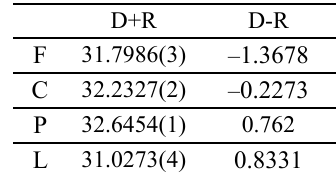
Internal Learning & Business